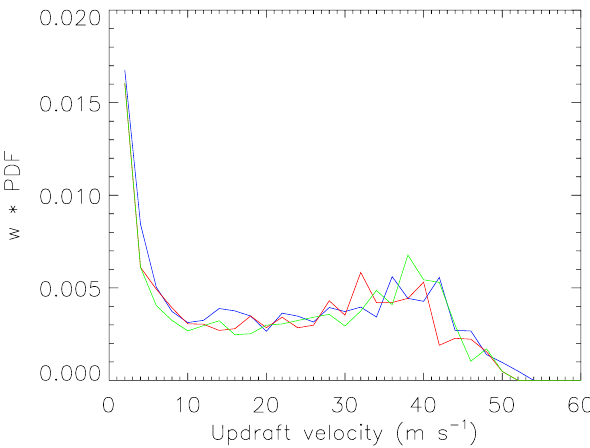
Fig. 5. Probability density functions (PDFs) of updraft velocity (multiplied by the value of vertical velocity) for the baseline model configuration (BASE) at a height of 8.25km and between t = 90 and 120 min. Results for pristine, moderately polluted, and highly polluted conditions are shown by blue, green, and red lines, respec- tively.